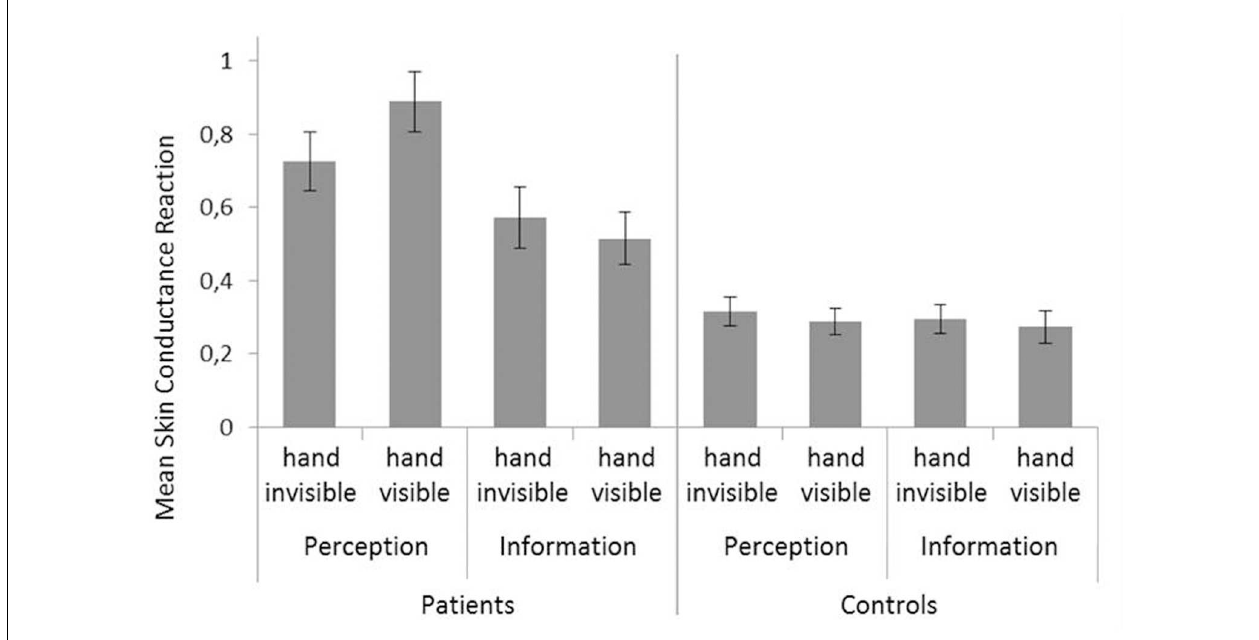
FIGURE 4 | Skin Conductance Reactions (SCR). Mean of all trials is shown (log-transformed data; SCR magnitude). Error bars represent standard errors of the